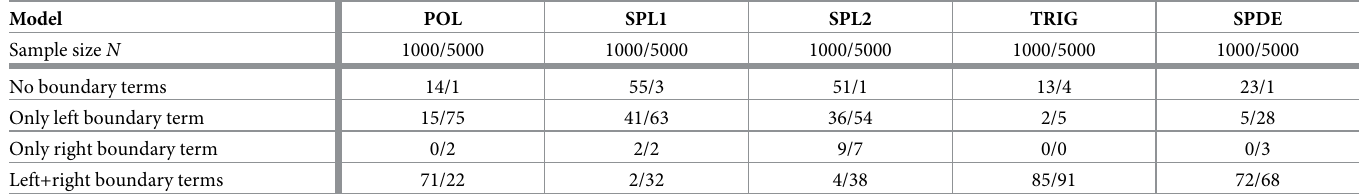
Table 8 contrasts the MISE of the different semiparametric methods without and with boundary terms for test cases 14 and 15. There is a substantial improvement for test case 14 and a small but systematic improvement for test case 15 due to the boundary terms. Also a moderate systematic increase of the probability of correct detection of the number of modes and bumps in the densities can be observed when allowing for boundary terms (not shown). Table 9 lists the mean boundary biases of the various estimators. The semiparametric tech- niques, already without boundary terms, exhibit significantly reduced boundary biases com- pared to the kernel density and diffusion estimators. The diffusion estimators are actually consistent at any boundary point as N ! 1 [7] but convergence is very slow. The inclusion of boundary terms greatly reduces the boundary biases of the semiparametric estimators. This is particularly pertinent at large sample size. The local likelihood density estimators in some cases also have very low boundary biases, though this is achieved by the choice of a rather small bandwidth which leads to very wiggly density estimates and the inability to detect the modality of the densities. For the cases with large boundary biases a pronounced improvement is seen when increasing the order of the local model. This is in accordance with the theory of